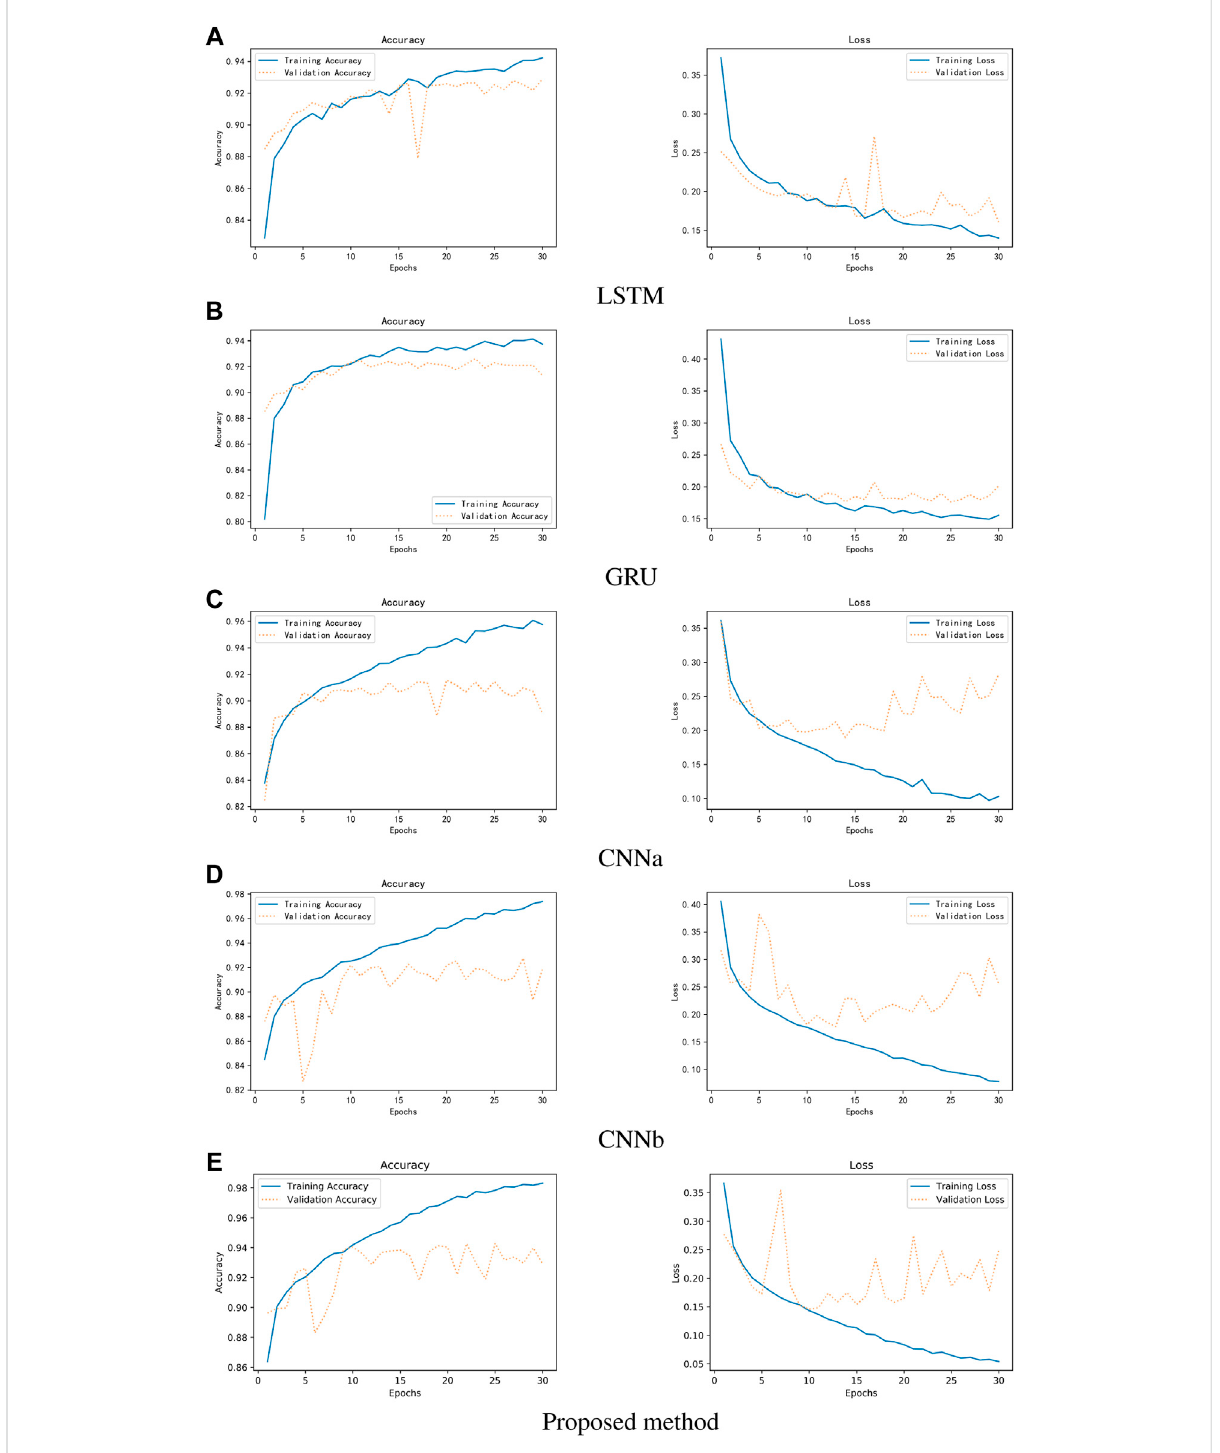
FIGURE 11 Comparison of three different networks between accuracy and loss. (A) LSTM (B) GRU (C) CNNa (D) CNNb (E) Proposed